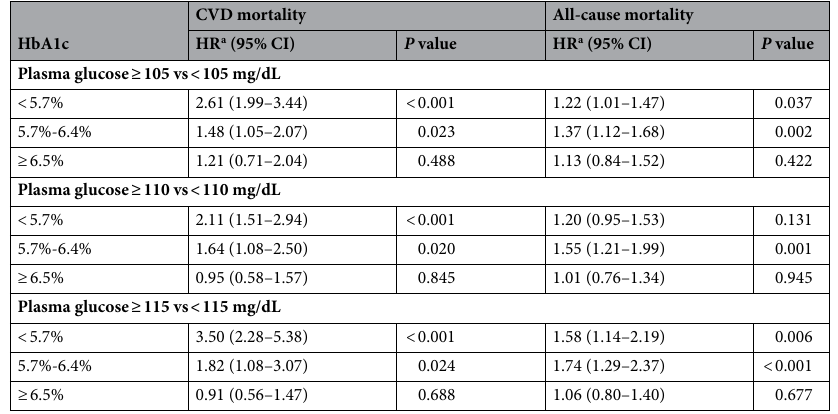
Table 3. Mortality risk associated with late non-fasting plasma glucose (dichotomous) in 5564 participants, stratified by HbA1c. CI, confidence interval; CVD, cardiovascular disease; HbA1c, hemoglobin A1c; HR, hazard ratio. a Adjusted for age, sex, ethnicity, obesity, education, poverty-income ratio, survey period, physical activity, alcohol consumption, smoking status, self-reported hypertension, self-reported hypercholesterolemia, and natural log-transformed HbA1c.